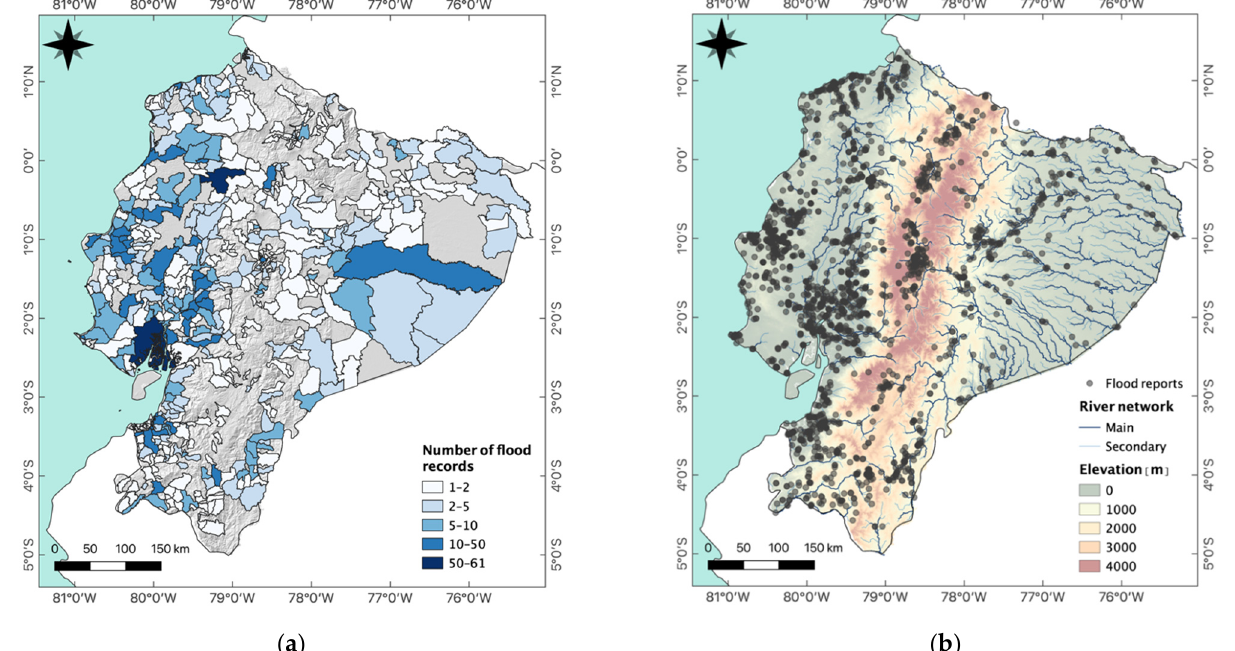
Figure 3. Historical flood events from the derived dataset (2007–2019): ( a ) Number of events per administrative level 3 (Parroquia) based on the 3365 historical records; ( b ) Location of the historical flood reports (2194) that included coordinates. Table 4. Number of flash flood identifiers assigned per historical flood event.